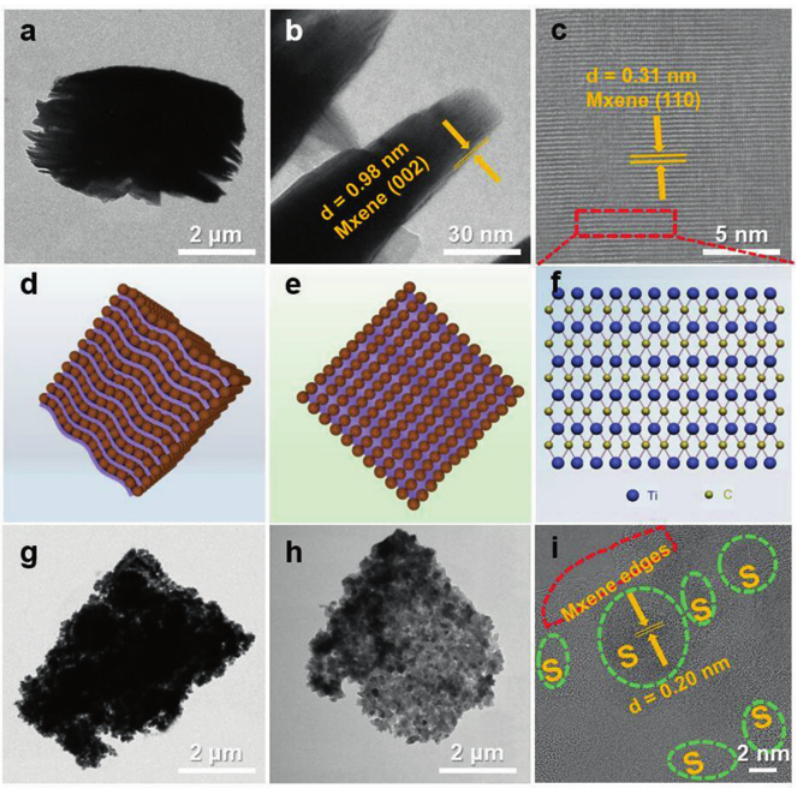
Figure4: (a,b)TEMimagesofTi 3 C 2 T x Mxene. (c) HR-TEM image of Ti 3 C 2 T x Mxene. (d, e) The schematic diagram of three- dimensional network structure between sulfur and Ti 3 C 2 T x Mxene. (f) Schematic of the molecular model of Ti 3 C 2 T x Mxene.